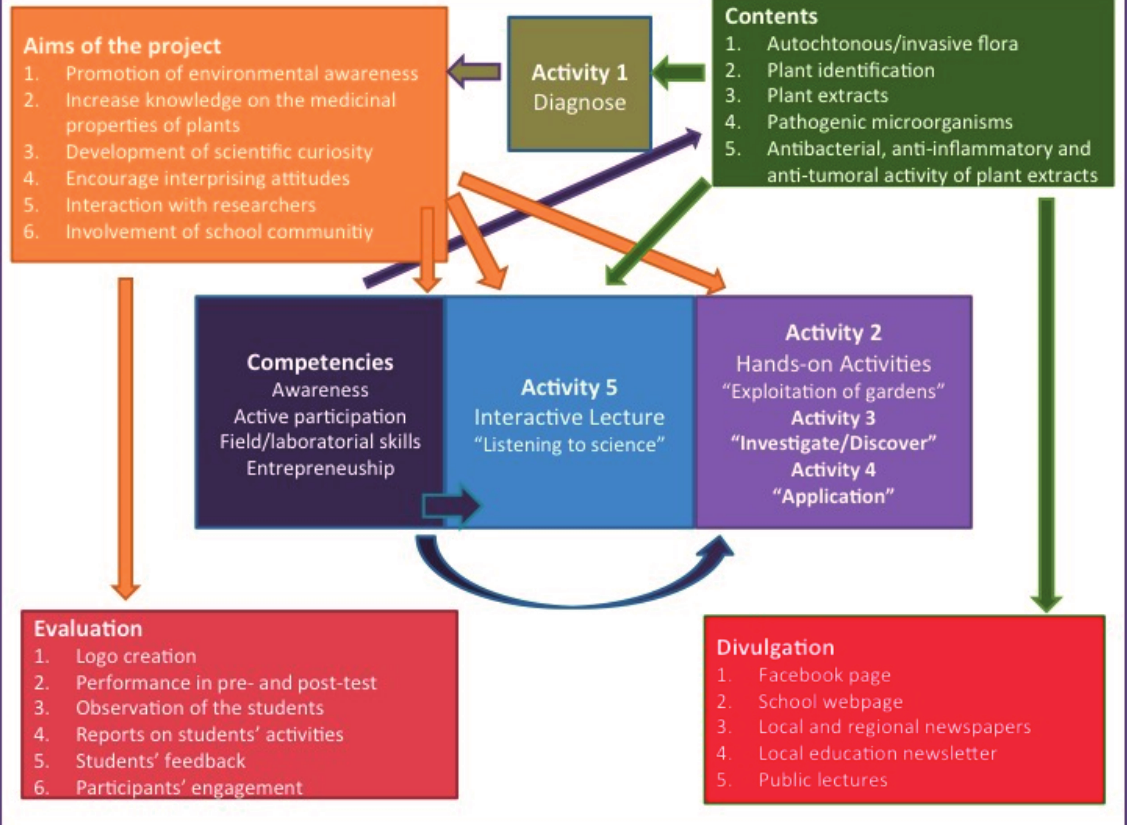
Figure 1. Diagram illustrating the rationale of the